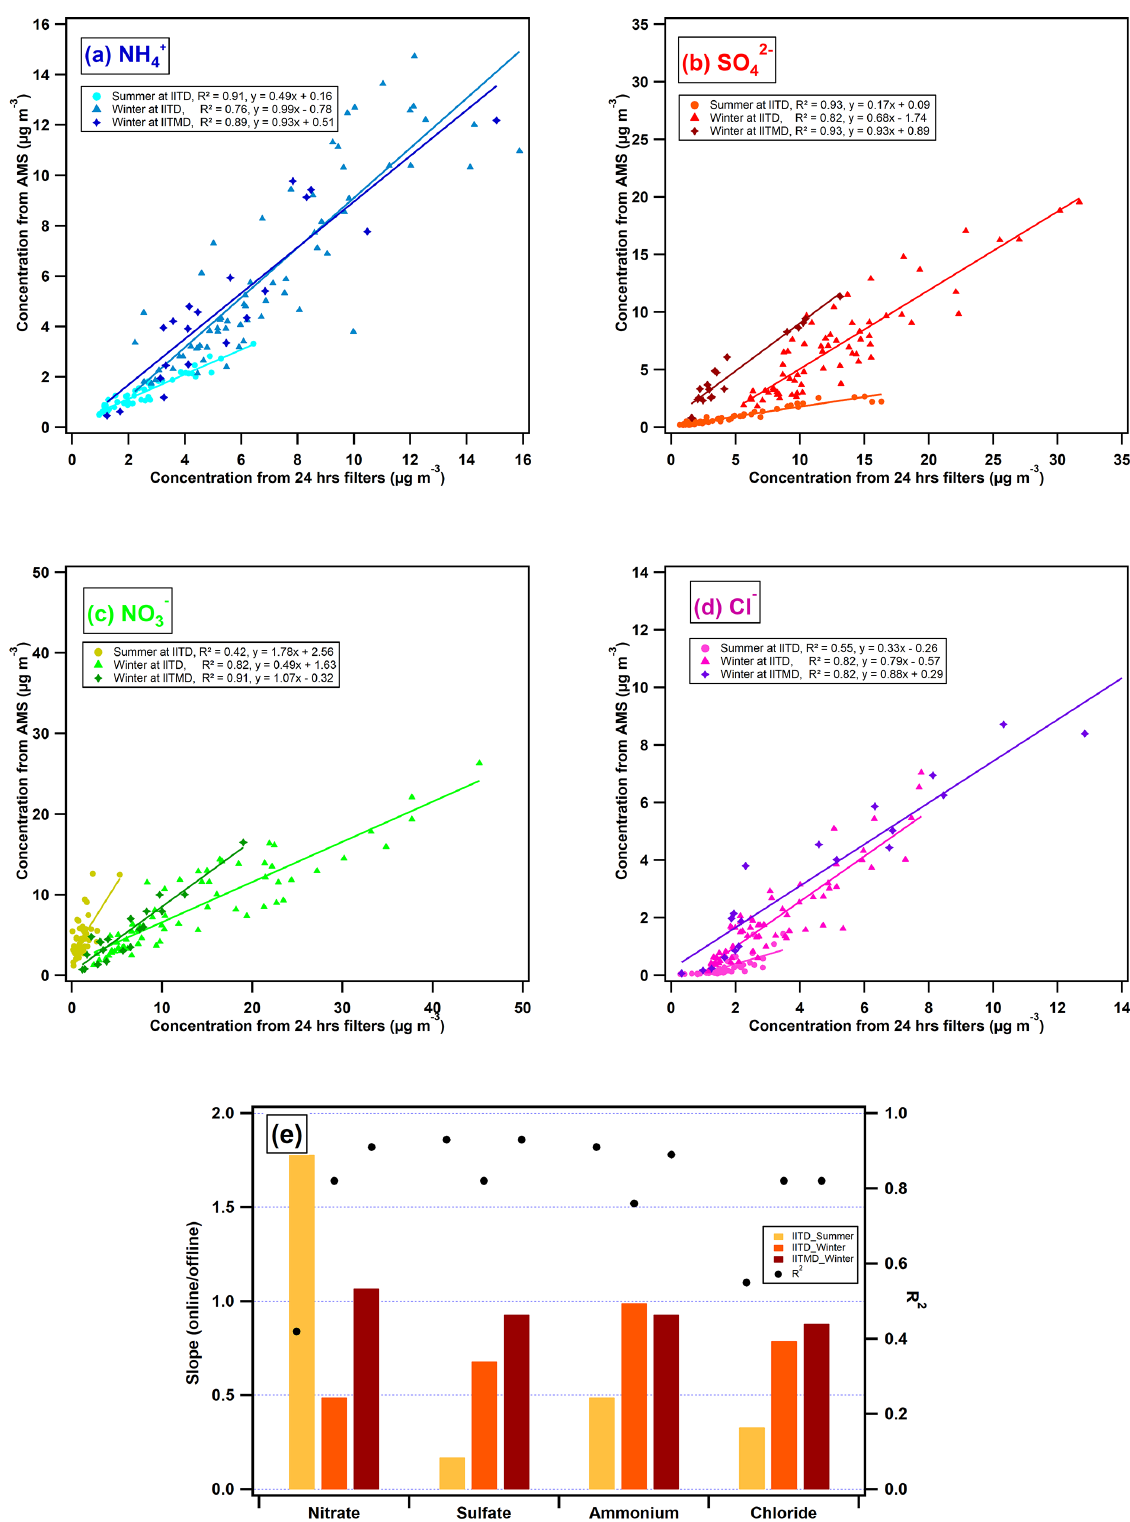
Figure 3. Scatterplots between online- and offline-measured (a) NH 4 + , (b) SO 42 − , (c) NO 3 − , and (d) Cl − concentrations and (e) compari- son of slopes (online / offline) and R 2 of the measured inorganic ions in PM 2 . 5 during the summer and winter campaigns at IITD and during the winter campaign at